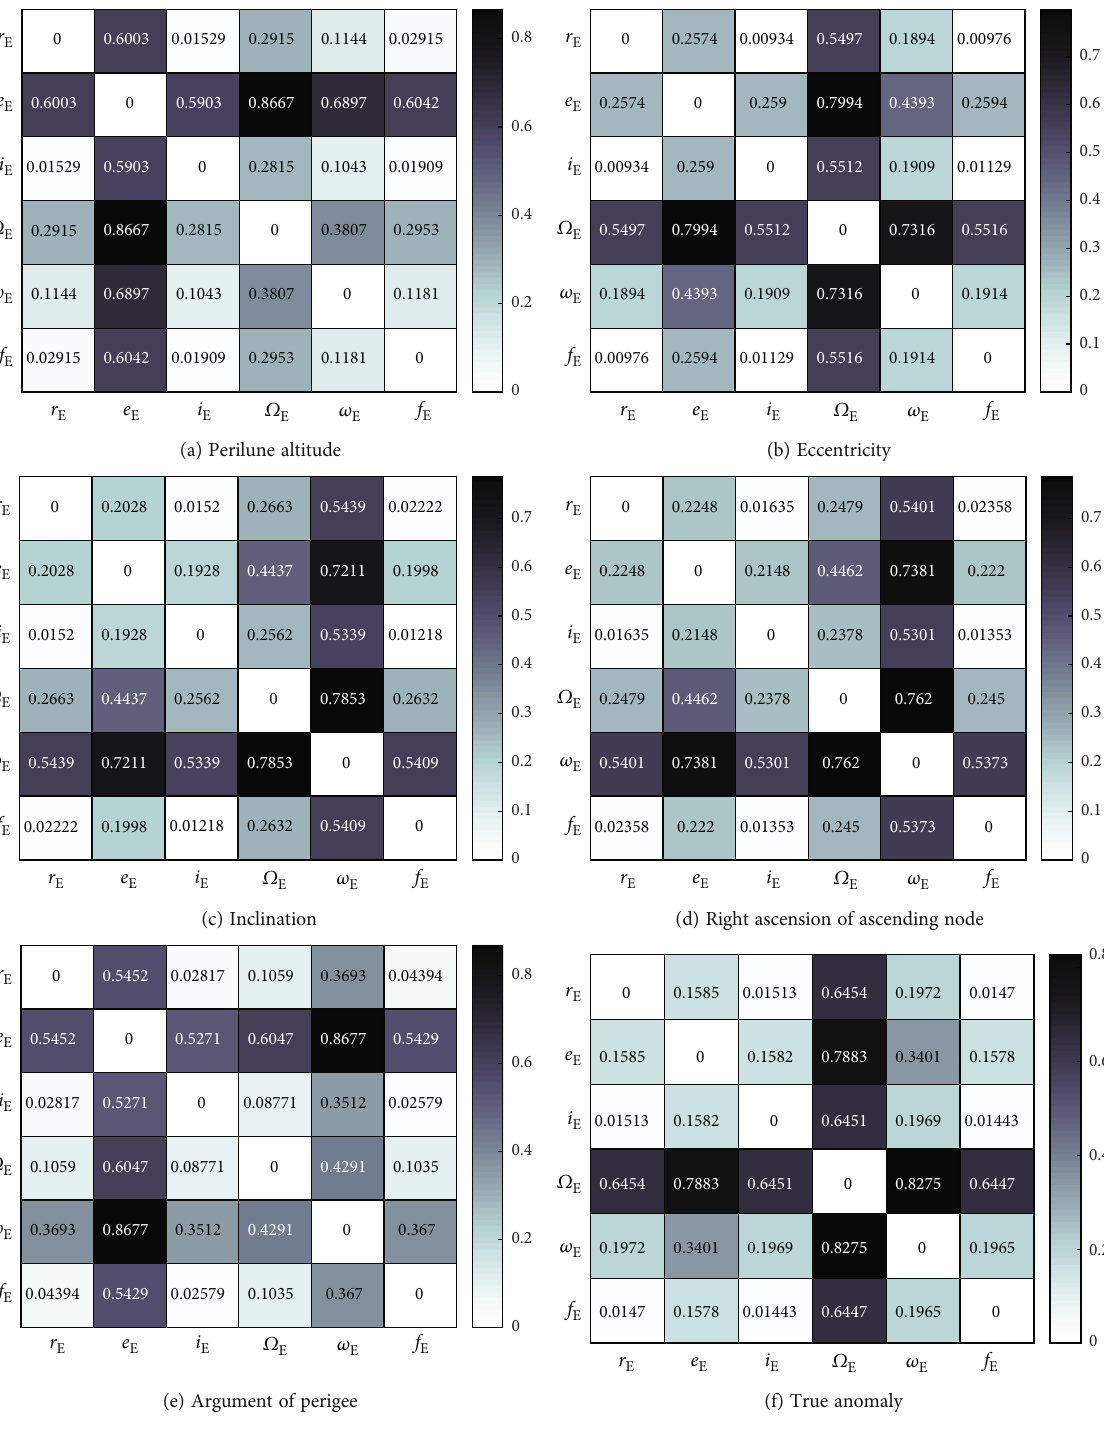
Figure 13: Sensitivity index for combination of orbital